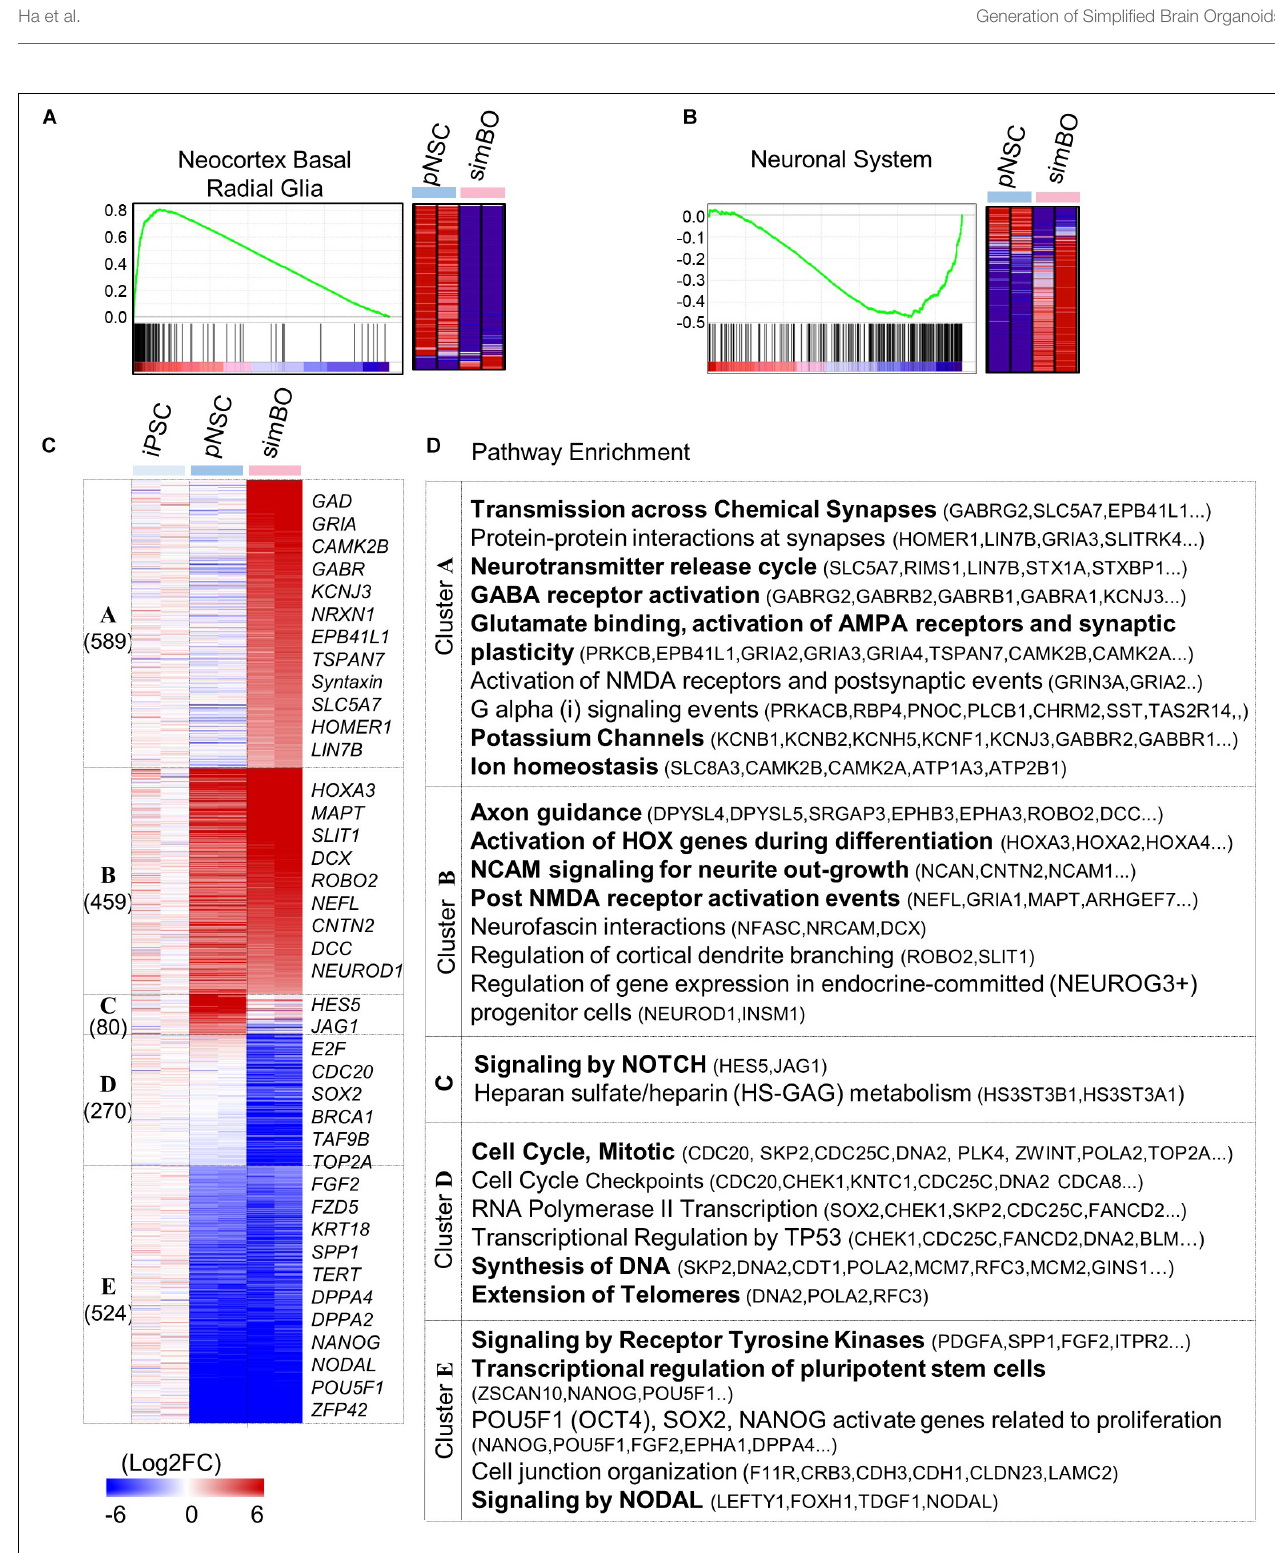
FIGURE 2 | Transcriptomic analysis of simBOs. (A,B) Enrichment plot and Heat map for the molecular signature of Neocortex Basal radial glia (A) and neuronal system (B) analyzing by gene set enrichment analysis of pNSC and simBOs. (C) Heat map of differentially expressed genes among iPSCs, pNSCs, and simBOs. Expression value was normalized to those of iPSCs. Cluster name and gene number in each cluster were indicated in left panel and representative gene names in each cluster were indicated in the right panel. Color scale of expression value were presented in lower panel. (D) Chart describing representative enrichment reactome pathways and entities related to differentially expressed genes in each